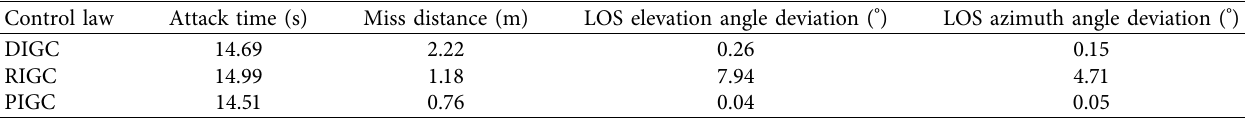
Table 1: Simulation results of Case